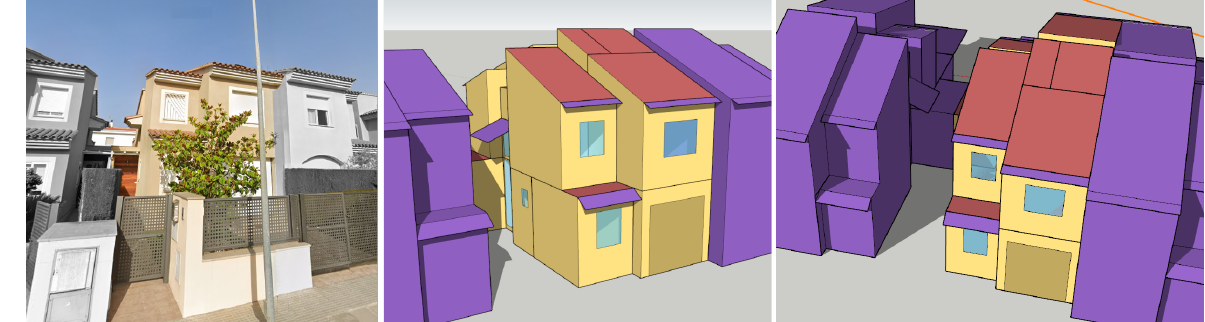
Figure 2. Semi-detached house under study. Real image and OpenStudio